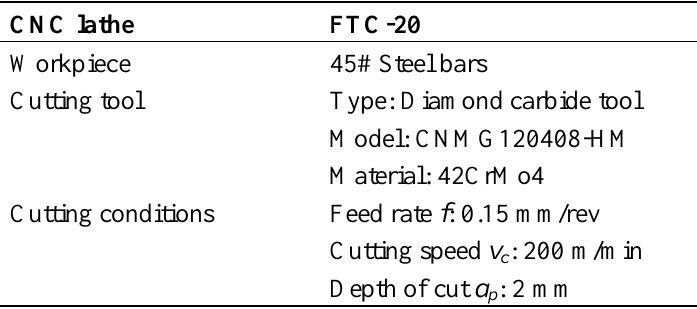
Table 1. Experimental conditions.